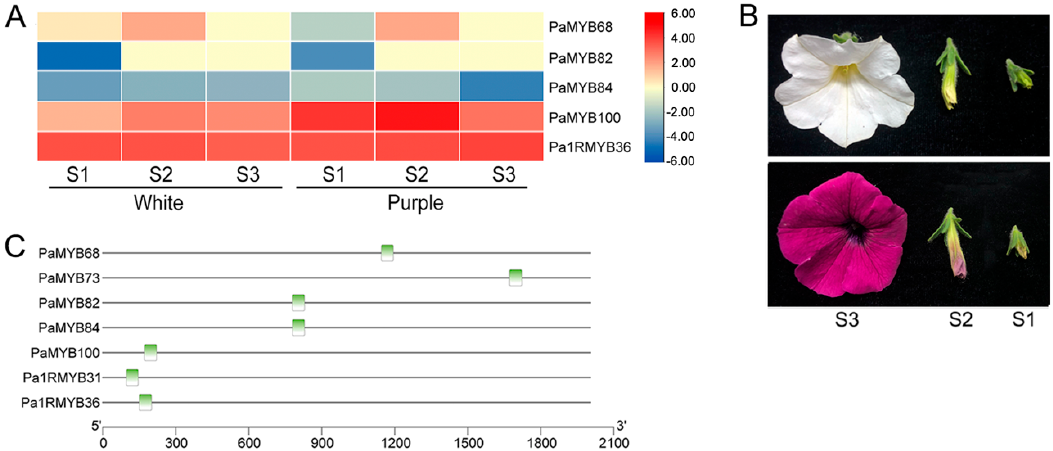
Figure 6. The expression and promoter analysis of 7 PaMYB genes that contained flavonoid biosynthetic regulation elements: ( A ) Heatmap showed the expression pattern of 5 PaMYBs in different coloration stage of white and purple petunia. S1 indicates budding period, S2 indicates extension period, S3 indicates blooming period; ( B ) The pictures of white and purple flowers; ( C ) The distribution of flavonoid biosynthetic regulation elements in 7 MYB genes. Green box indicates the flavonoid biosynthetic regulation elements.